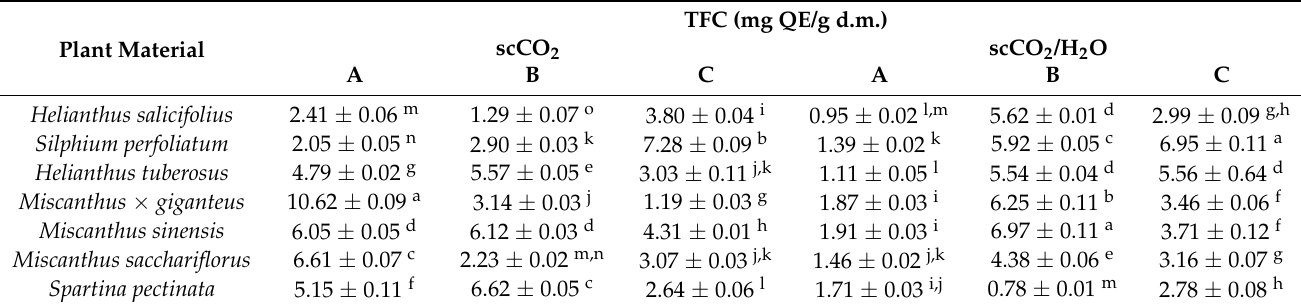
Table 2. Influence of extraction conditions (scCO 2 or scCO 2 /H 2 O) and harvest time ((A) June, (B) October and (C) February) on total flavonoid content (TFC)* in extracts from herbaceous species.